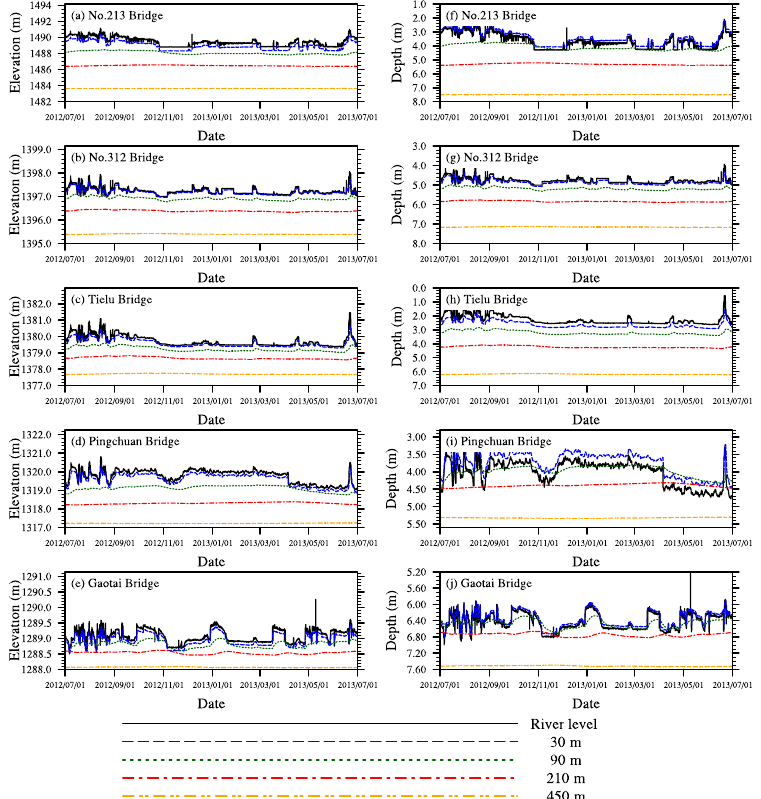
Figure 9. Time series of simulated (a–e) water head elevations and (f–j) water table depths at 30, 90, 210, and 450m from streams and the observed river water levels at the five left riverbanks of stations at (a, f) 213 Bridge, (b, g) 312 Bridge, (c, h) Tielu Bridge, (d, i) Pingchuan Bridge, and (e, j) Gaotai Bridge.